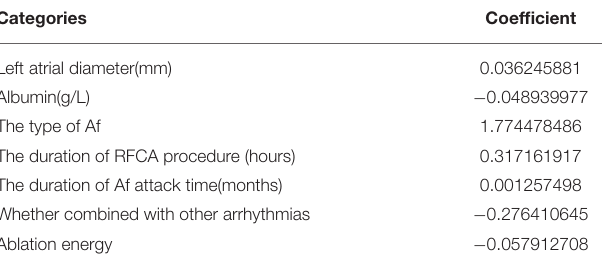
TABLE 2 | The least absolute shrinkage and selection operator (Lasso) regression screening for atrial fibrillation (Af) recurrence outcome performed once at